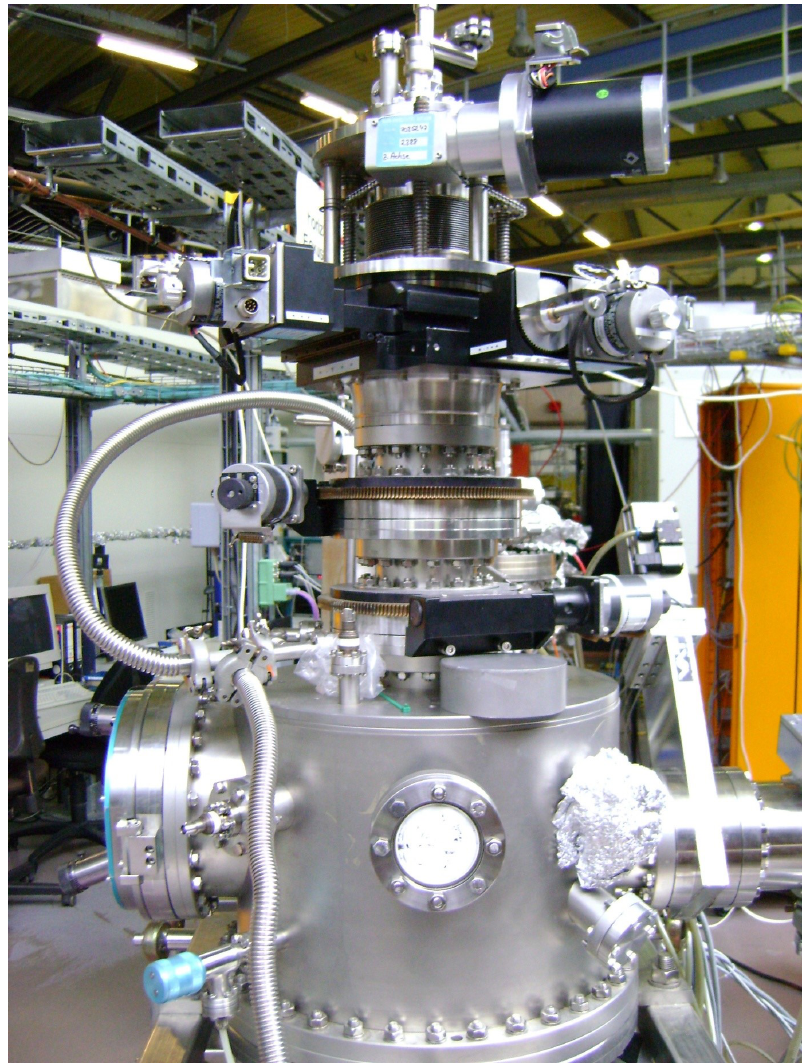
Figure 1: View of the ALICE